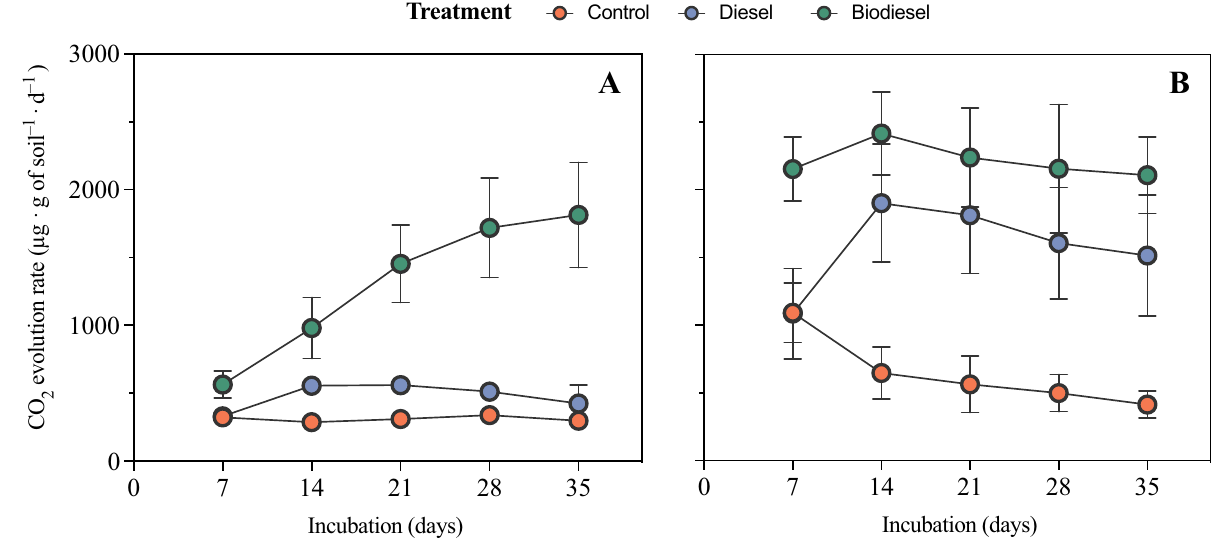
Figure 1. Soil microbial activity (CO 2 evolution) measurements in an upper ( A ) and lower ( B ) slope soil under three different treatments (control biodiesel and diesel) after 35 days. Error bars represent standard deviations (n =